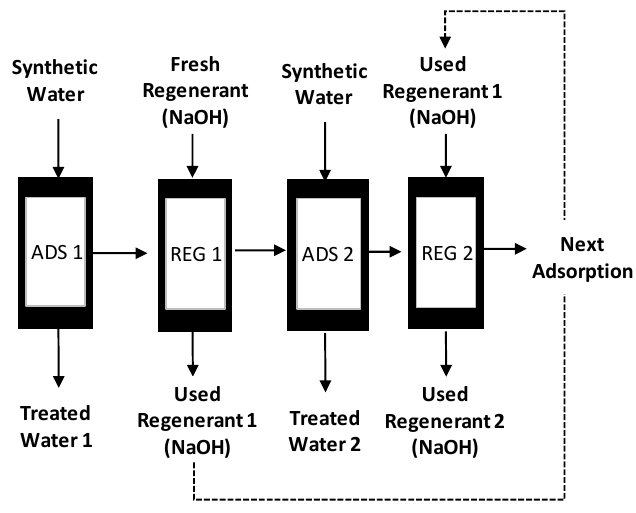
Figure 3. Schematic view of adsorption and regeneration Figure 3 . Schematic view of adsorption and regeneration experiments.